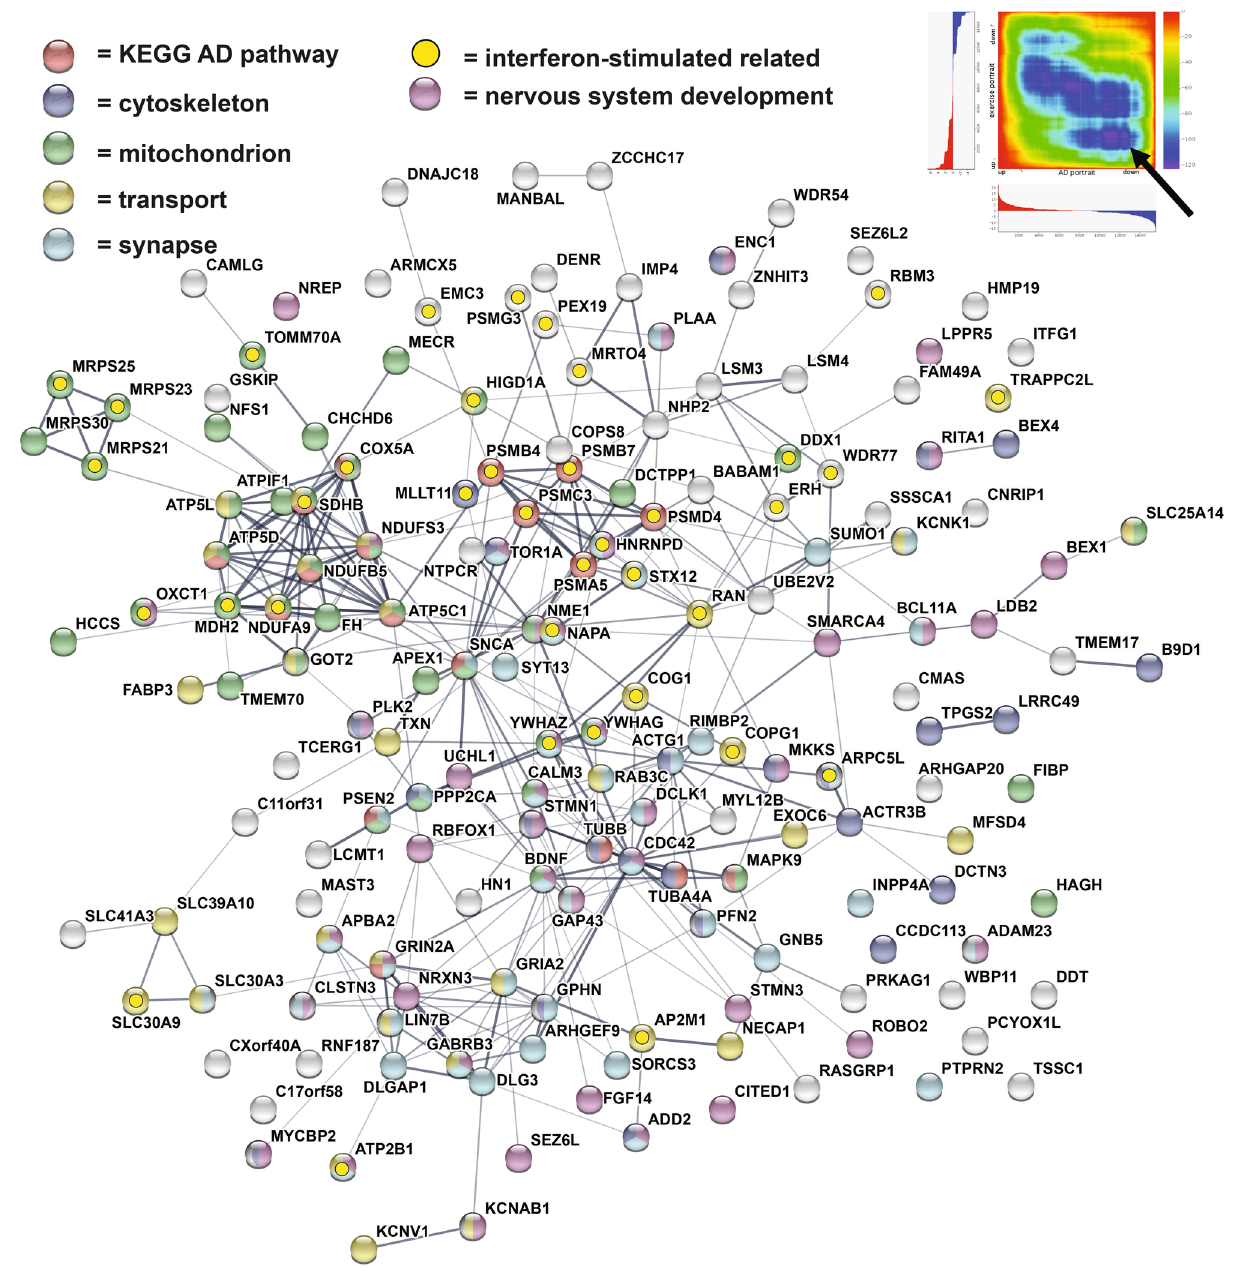
(green); cytoskeleton (light yellow); and interferon-stimulated related (yellow). Upper right shows RRHO heat map 111 comparing exercise composite (Y axis) and AD portrait (X axis). Arrow highlights reversal of downregulated genes in AD by